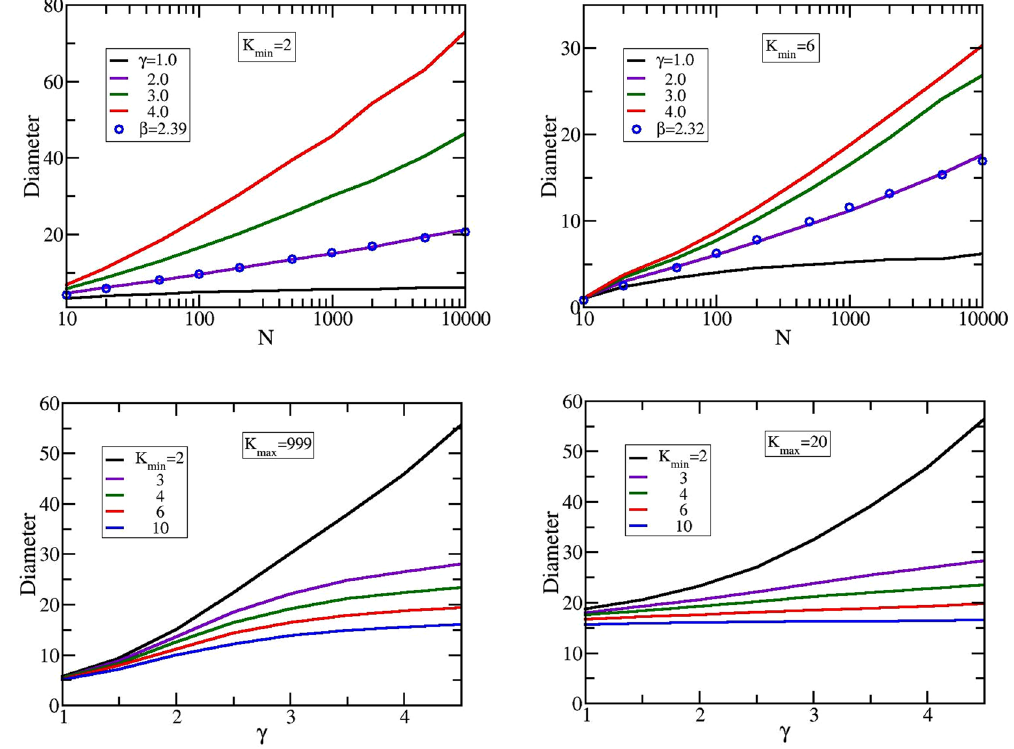
Figure 3. Diameter of GSFNs as a function of N (row above) and as a function of γ (row